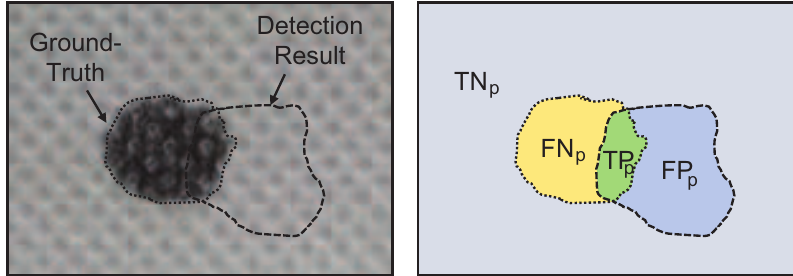
Figure 8. Definition of the TN p , FN p , TP p , and FP p indicators.